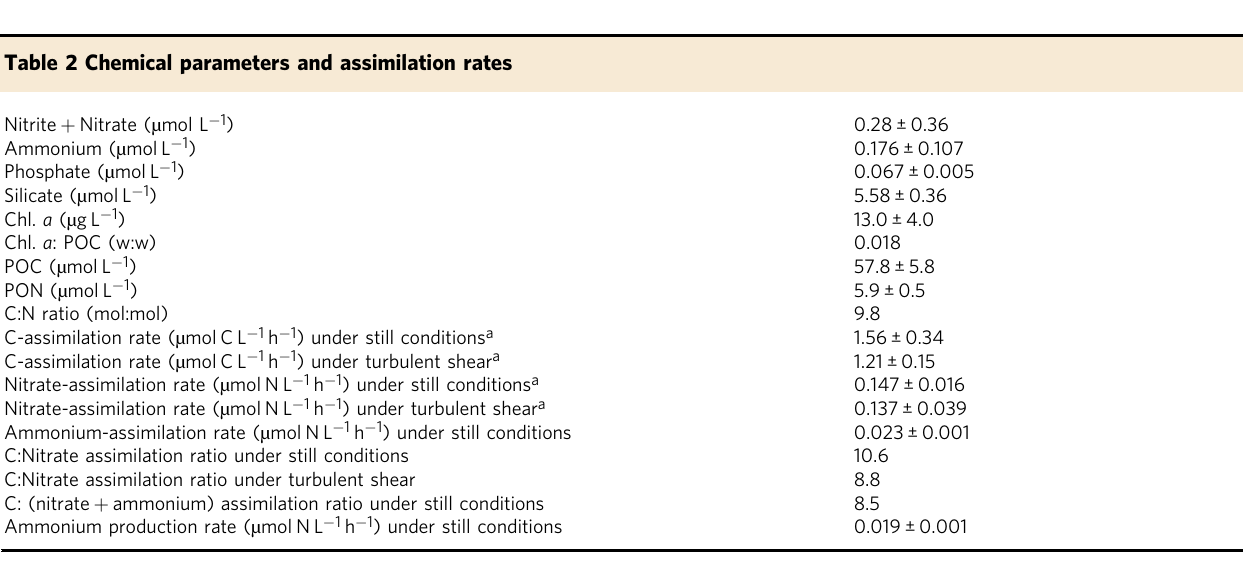
turbulent shear (two-way ANOVA, p > 0.13, DF:4).